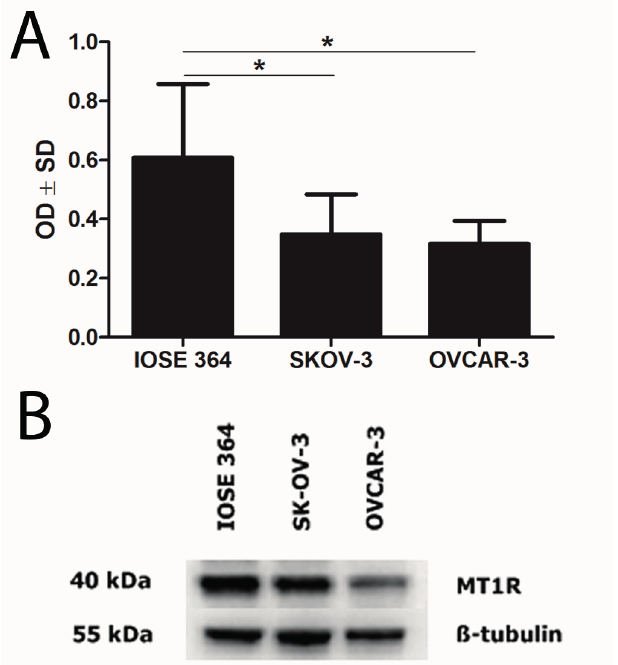
Figure 3. Western blot analysis of MT1 expression in ovarian cell lines ( B ). Densitometric measurement of the bands demonstrates higher MT1 protein contents in normal ovarian cell line (IOSE 364) than in ovarian cancer cell lines (SKOV-3 and OVCAR-3) ( A ). Statistically significant ( * p < 0.05) differences were noted between cell lines IOSE 364 and SKOV-3, IOSE 364 and OVCAR-3. OD: optical density; SD: standard